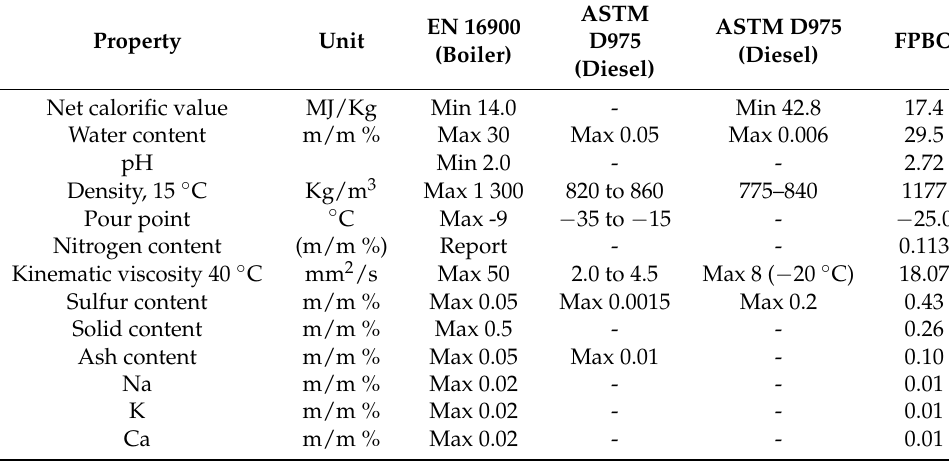
Table 2. Properties of sample FPBO.